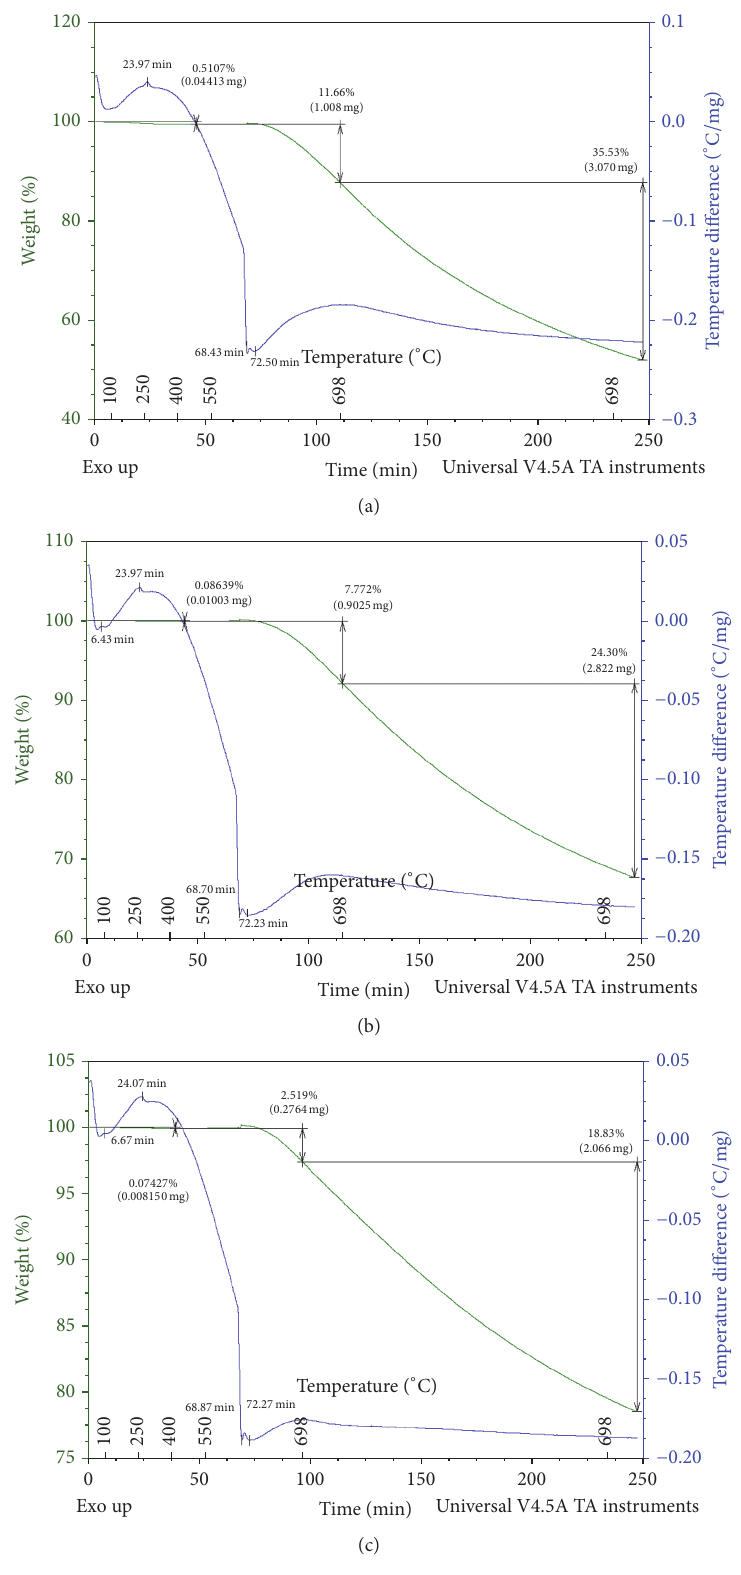
Figure 7: DSC/TGA results for (a) graphite, SiC-coated graphite prepared (b) at reaction zone (1) and (c) at reaction zone (2) with air blowing (100mL/min). 10 ∘ C/min to 700 ∘ C in Ar gas and holding 180 min in